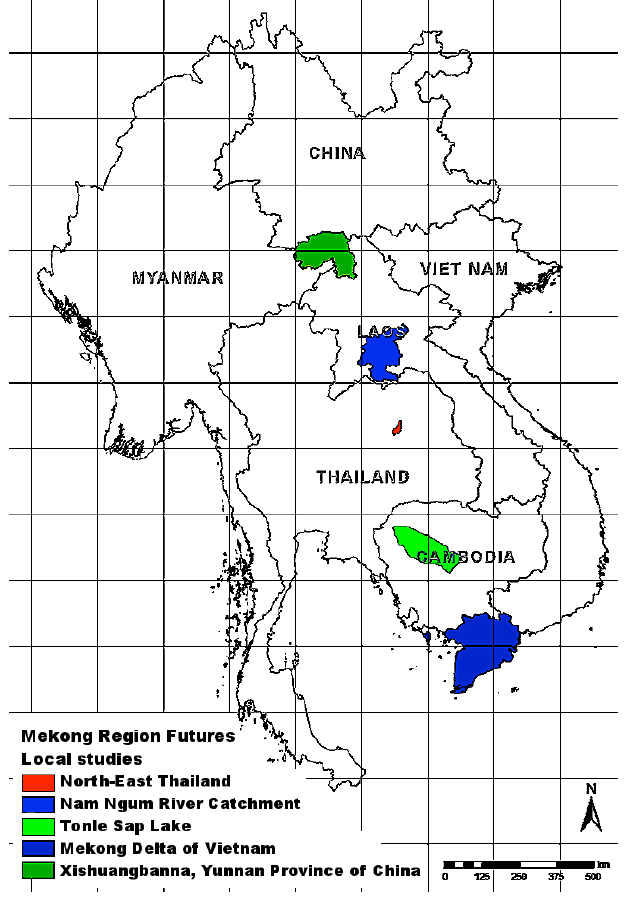
Fig. 1 . The Mekong region and the five local studies considered in this study, including the two documented in this